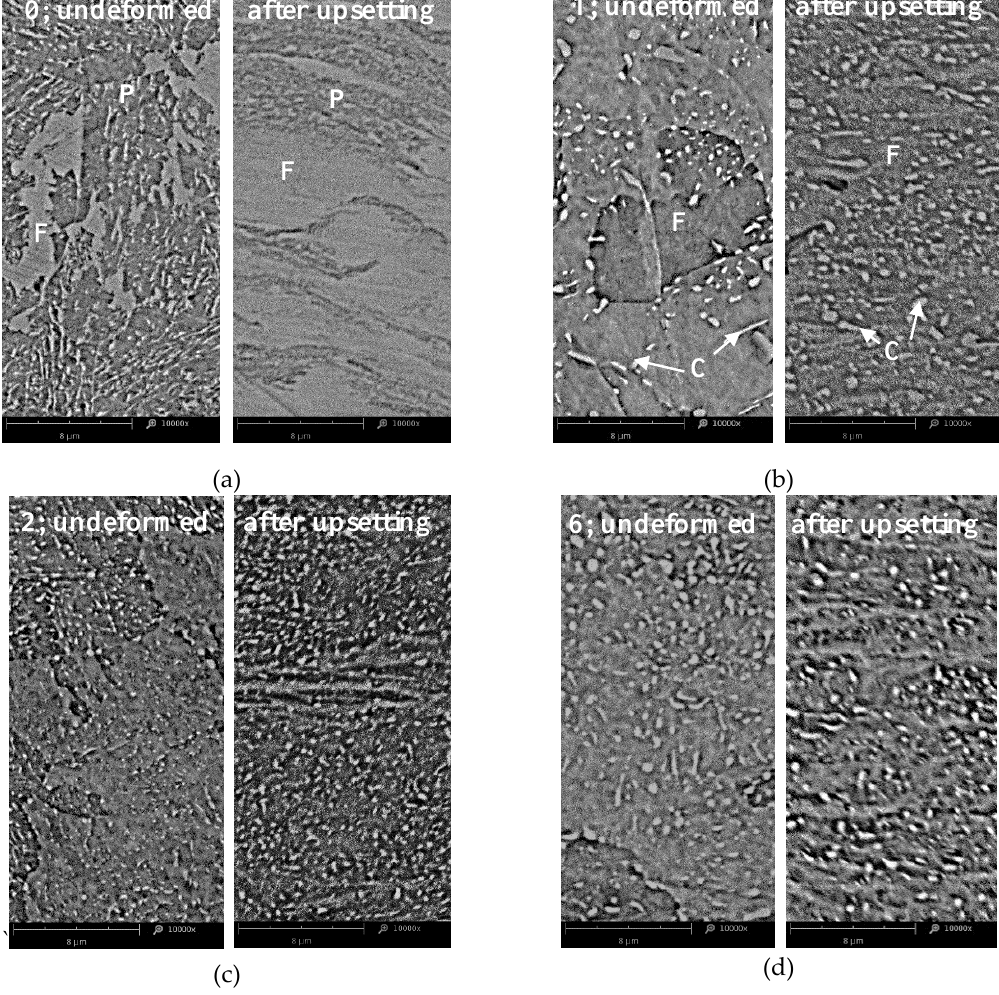
Figure 6. Effect of upsetting on the microstructure of 42CrMo4 steel samples: ( a ) as-received, ( b ) annealed according to scheme no. 1; ( c ) annealed according to scheme no. 2; ( d ) annealed according to scheme no. 6; P—pearlite, F—ferrite, C—cementite, SEM.